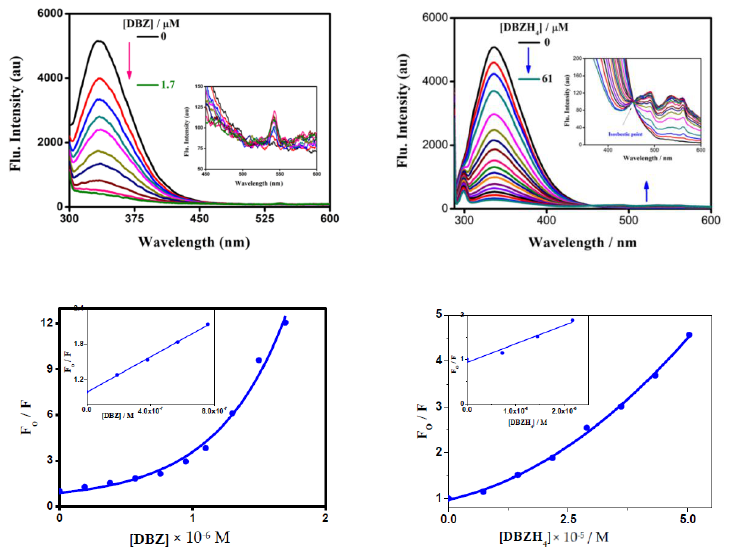
Figure 1. Fluorescence spectra of BSA (19 μM ) in the presence of different concentrations of DBZ ( left ) and DBZH 4 ( right ) in water. Dynamic quenching occurs when the excited fluorophore is deactivated by interact- ing with the quencher molecule in solution, whereas static quenching occurs via the crea- tion of a non-fluorescence ground-state complex between the fluorophore and the quencher. The dynamic quenching constant increases with temperature, whereas static quenching constants decrease with increasing temperature [27]. The quenching data can be derived from the Stern – Volmer equation (Equation (1)) [27,28] F O /F = 1 + K SV [Q] (1) where F 0 and F represent the fluorescence intensities in the absence and presence of a quencher, K SV is the Stern – Volmer constant, τ 0 is the average lifetime of the molecule with- out quencher, and [Q] is the concentration of the quencher. The K SV values are 24.7 × 10 5 and 0.7 × 10 5 M − 1 for DBZ and DBZH 4 , respectively, indicating that (i) both complexes bind efficiently to BSA compared to that reported in the literature [29]; (ii) DBZ binds to BSA nearly 30-fold more than DBZH 4 (Table 1). This difference in BSA affinity can be explained on the basis of ligand flexibility and complex structure configuration. The lig- and in complex DBZ is rigid and adopts the complex arrangement in the square-pyramid and leaves a coordination site empty that is less sterically hindered. On the other hand, the ligand in complex DBZH 4 is more versatile and adopts the complex structure with more of a trigonal bipyramidal form, which makes it more difficult for BSA to bind. The K q values were derived from Equation (2), K q = K sv / τ 0 (2) where τ 0 is the average lifetime of BSA in the absence of the quencher. The calculated K q values for the formed BSA-complex systems are 5.4 × 10 14 M − 1 s − 1 and 0.15 × 10 14 M − 1 s − 1 .